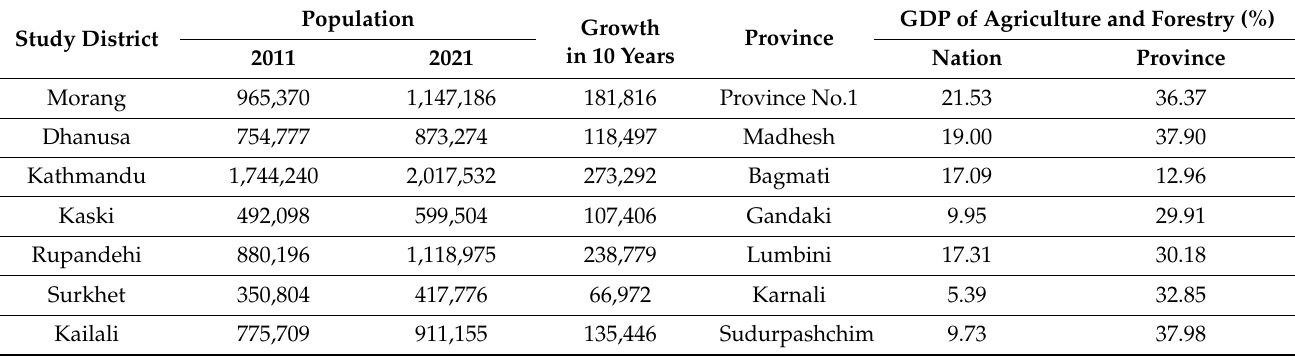
Table 7. Population number of the seven districts in 2011 and 2021 from the census of Nepal. National GDP represents the proportion of agriculture and forestry GDP in the province to that of Nepal, and provincial GDP means the proportion of agriculture and forestry GDP to the province’s total